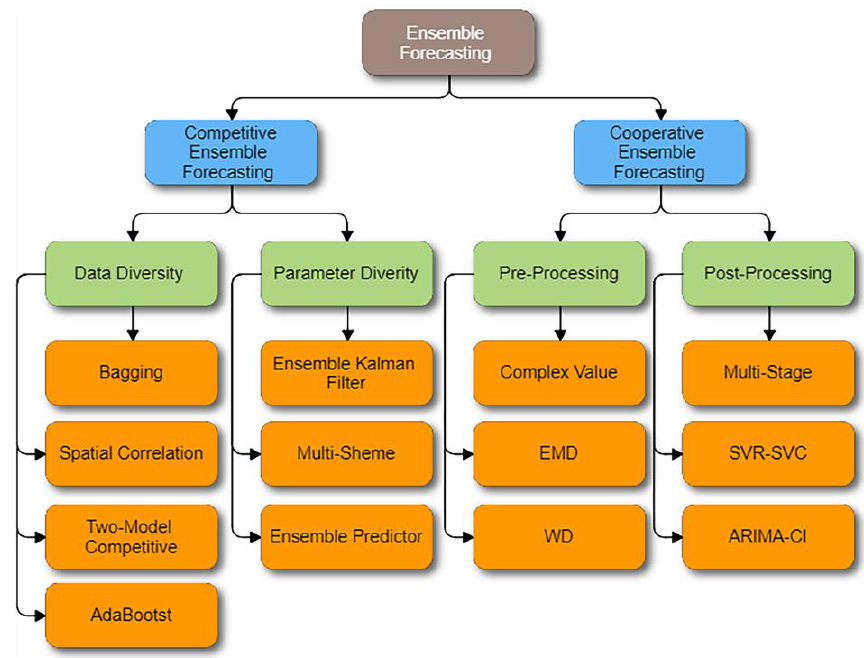
Figure 5. Ensemble prediction classification.